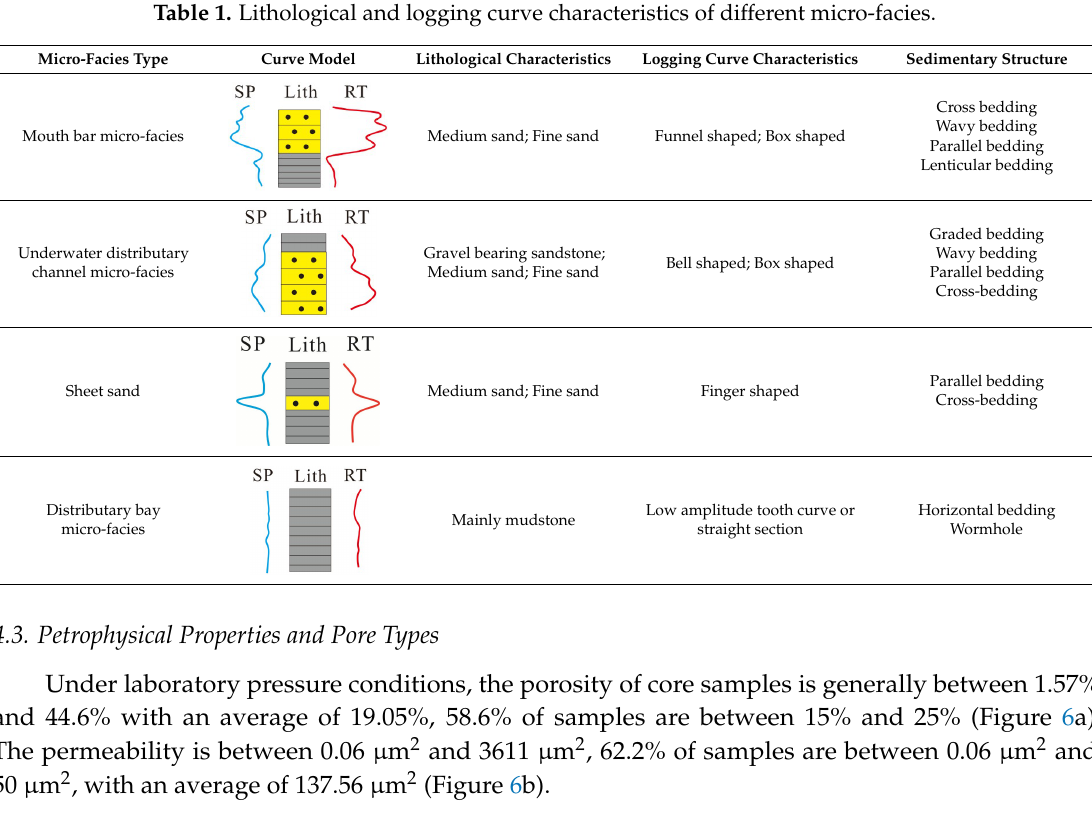
Table 1. Lithological and logging curve characteristics of different micro-facies.